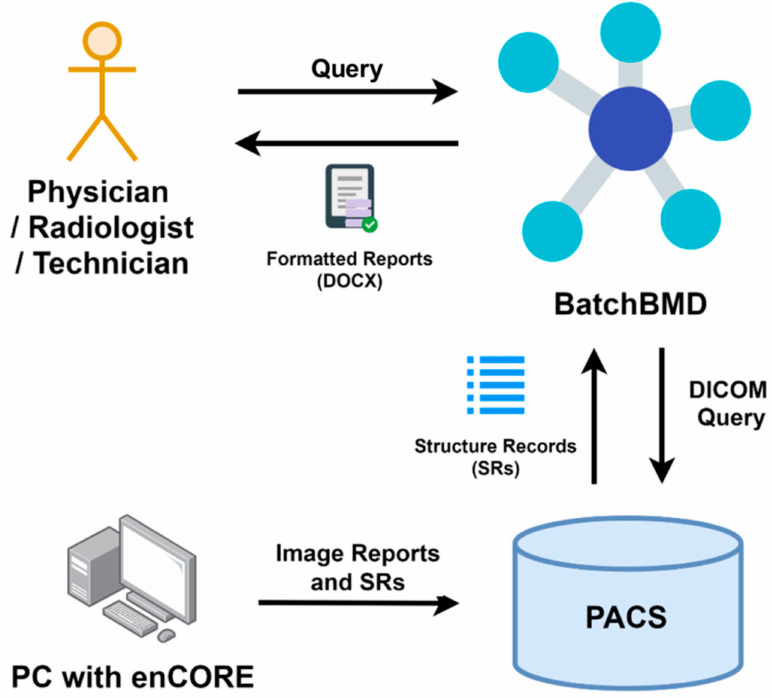
Figure 1. Data flow diagram.